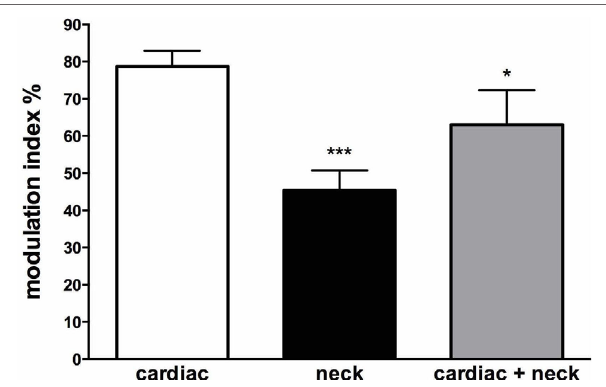
FiGURe 11 | Mean modulation indices (see Methods) calculated from the cross-correlation histograms between muscle sympathetic nerve activity (MSNA) and ECG at rest ( cardiac ), MSNA and neck angle during sinusoidal neck displacement ( neck ) and between MSNA and ECG during sinusoidal neck displacement ( cardiac + neck ). Neck modulation of MSNA was significantly lower than cardiac modulation at rest and cardiac modulation was significantly lower during neck stimulation. * P < 0.05; *** P < 0.001. Reproduced with permission from Bolton et al.